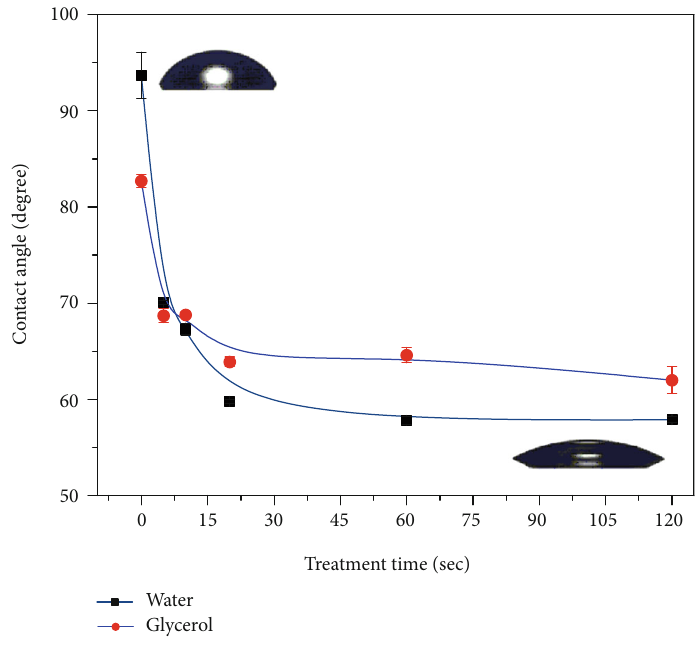
Figure 5: Variation of the contact angle of polypropylene with treatment time.